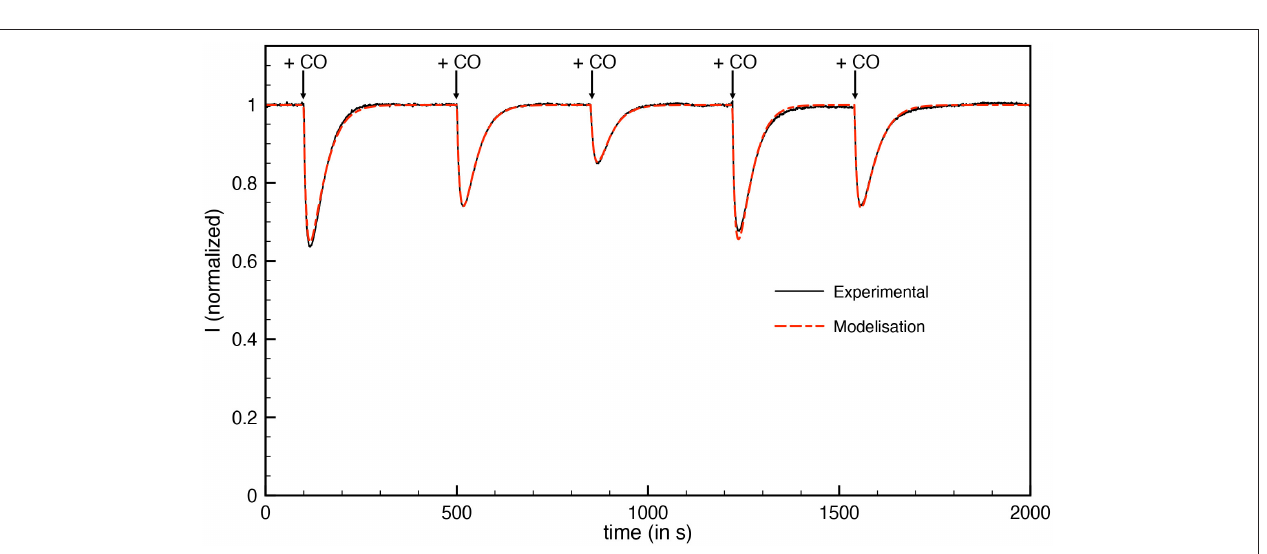
FIGURE 4 | Inactivation by CO of aerobically-purified Hnd hydrogenase adsorbed on PGE electrode. The black line corresponds to experimental data and the dashed red line corresponds to best fit of the model in Equation (1). [CO] = 288, 192, 96, 288, and 192 nM injected at respectively t = 100, 500, 850, 1,220, and 1,540 s; E = − 360 mV vs. SHE, T = 30 ◦ C, 1 bar H 2 , phosphate buffer pH 7, ω = 3,000